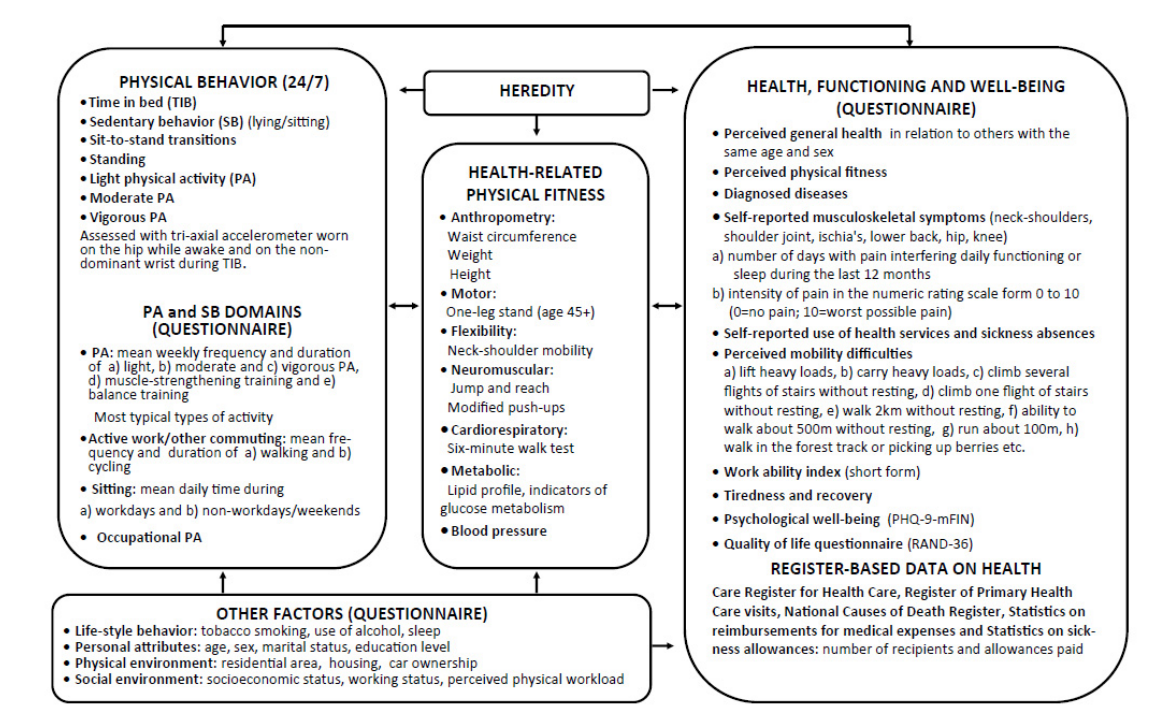
Figure 2. Assessment methods used in the FINFIT 2021 study.